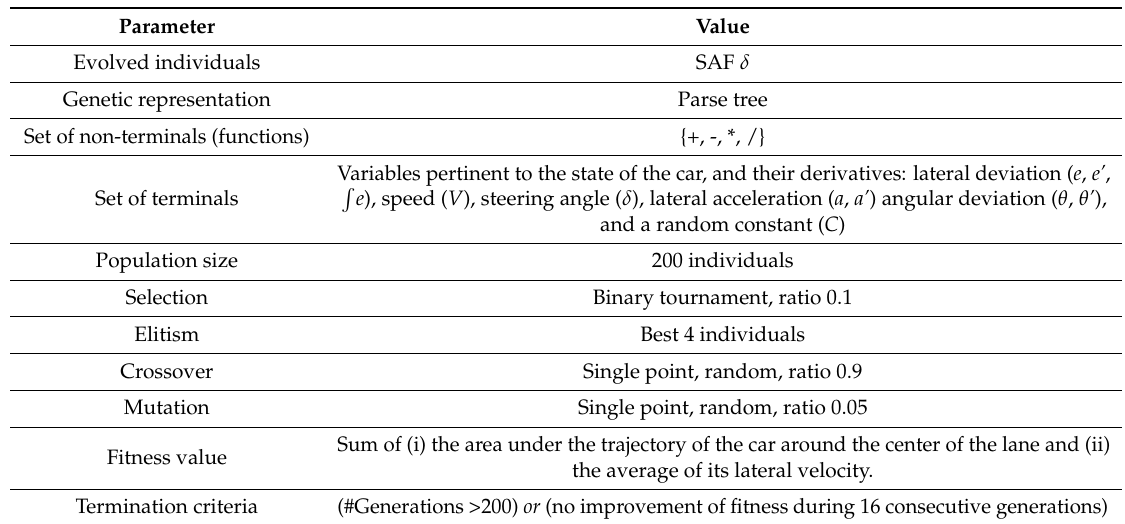
Table 4. Parameters of genetic programming